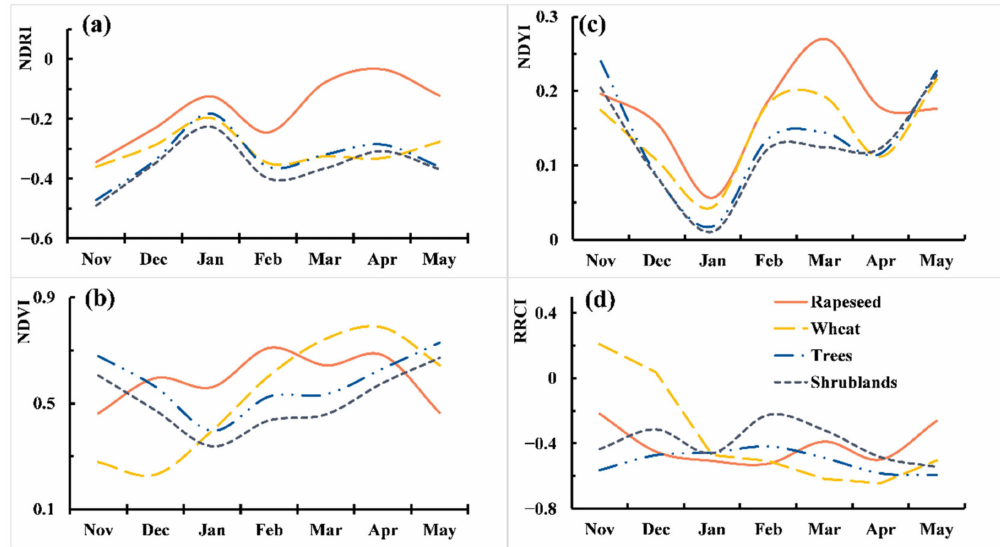
Figure 5. Temporal profile of different vegetation with the ( a ) Normalized Difference Rapeseed Index (NDRI), ( b ) Normalized Difference Vegetation Index (NDVI), ( c ) Normalized Difference Yellow Index (NDYI), and ( d ) Ratio Oilseed Rape Colorimetric Index (RRCI).